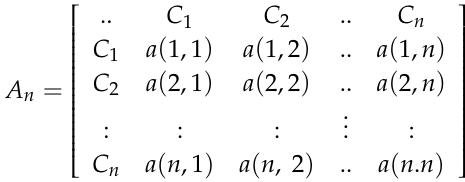
Table 3. Average random consistency (RI) [38,40].